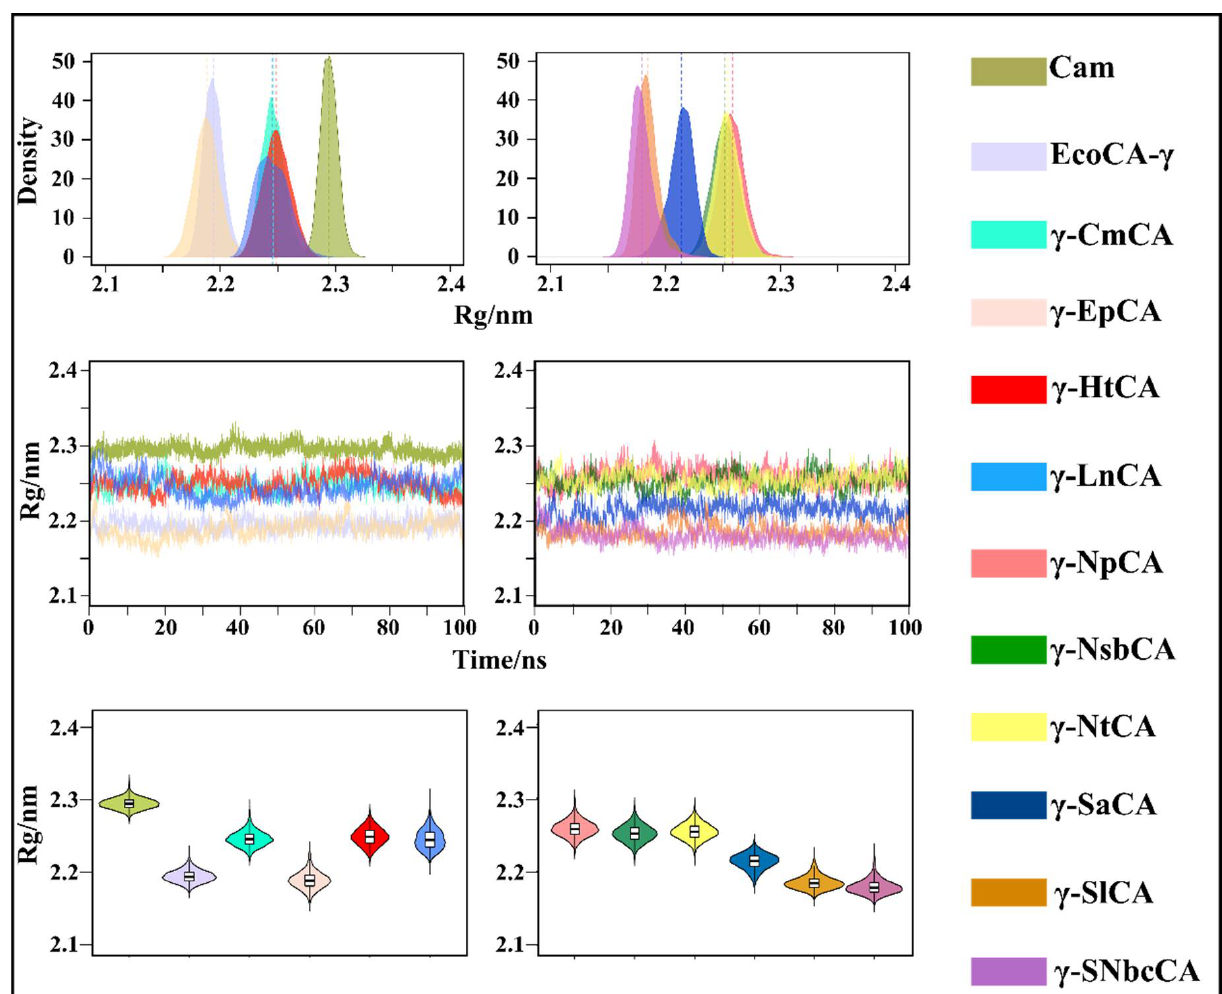
Figure 7. Radius of gyration (R g ) kernel density estimation (KDE) plots ( top ), line plots ( middle ), violin plots ( bottom ) of γ-CAs simulated. The mean R g for each γ-CA is depicted as a similar colored line to the KDE plot and as a black line in the violin plots.